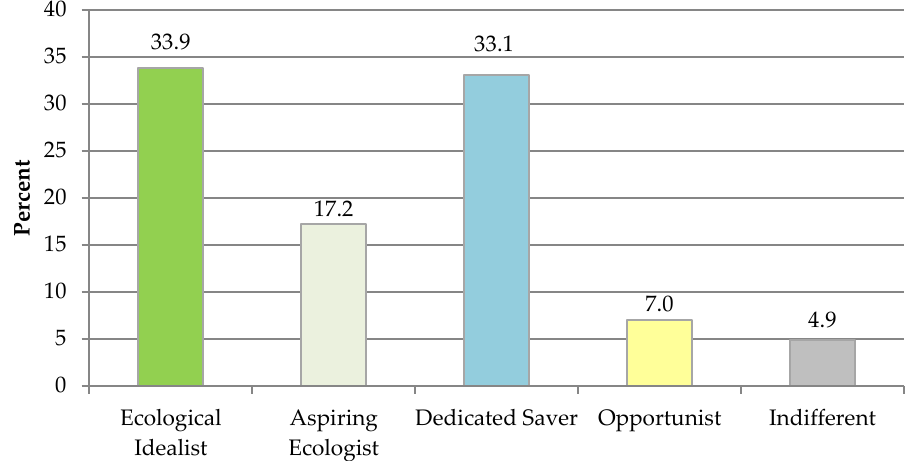
Figure 3. The respondents of the survey by the final segment membership.